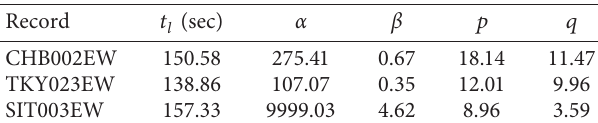
Figure 3: Comparison of truncated time series with corresponding original records in terms of velocity response spectrum. (a) CHB002EW and (b) TKY023EW. Table 1: Parameters of determination and PSD for truncated long- period